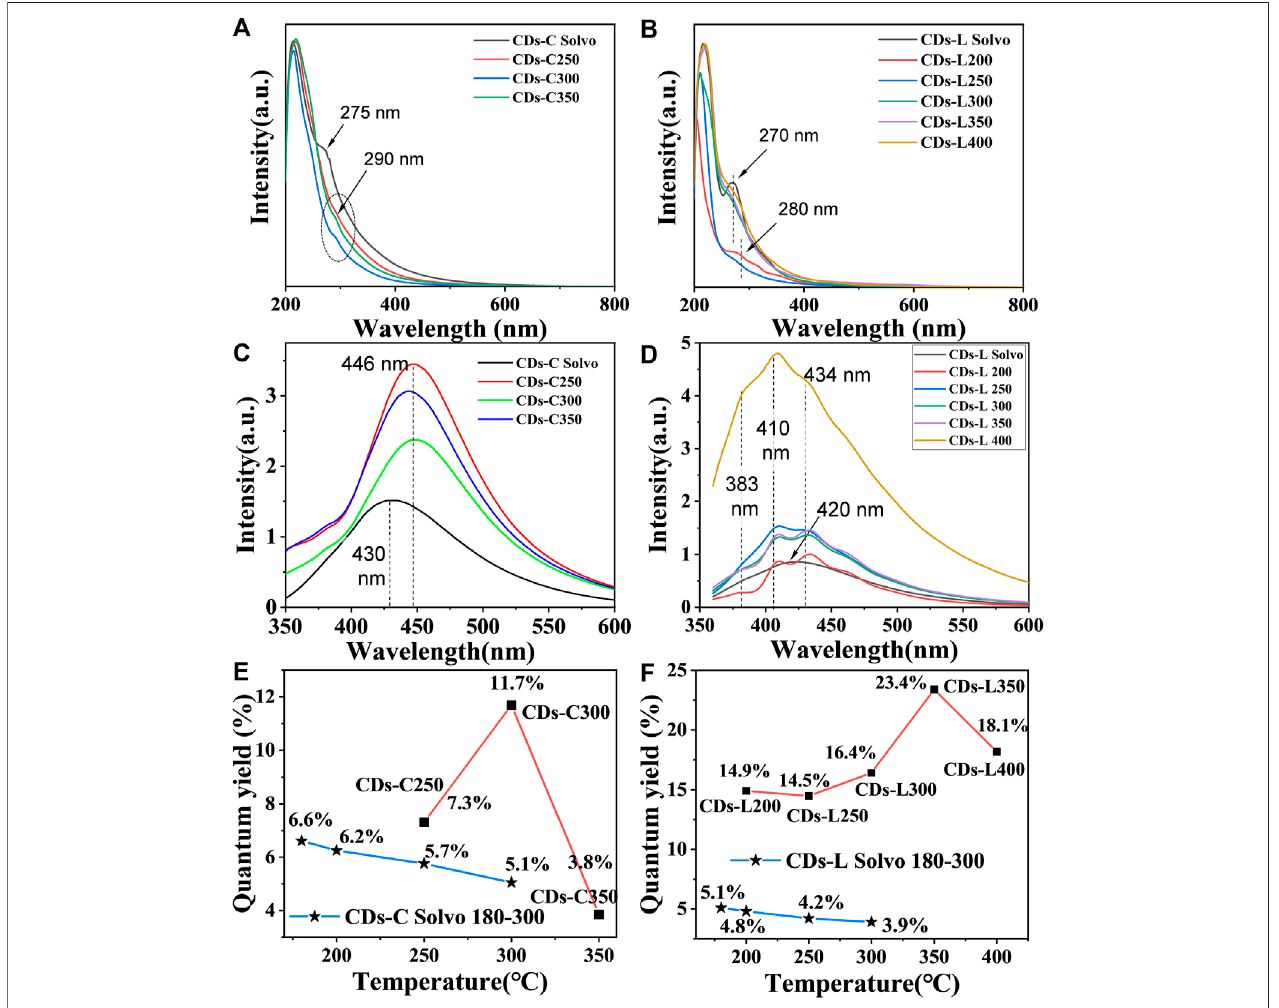
FIGURE 3 | (A,B) UV/vis absorption spectra of CDs based on (A) cellulose and (B) lignin in ethanol solution ( c = 1.0 mg/ml). (C,D) PL emission spectra of CDs based on (C) cellulose and (D) lignin in ethanol solution ( c = 1.0 mg/ml). (E,F) Dotted line plot of CDs quantum yield versus reaction temperature.